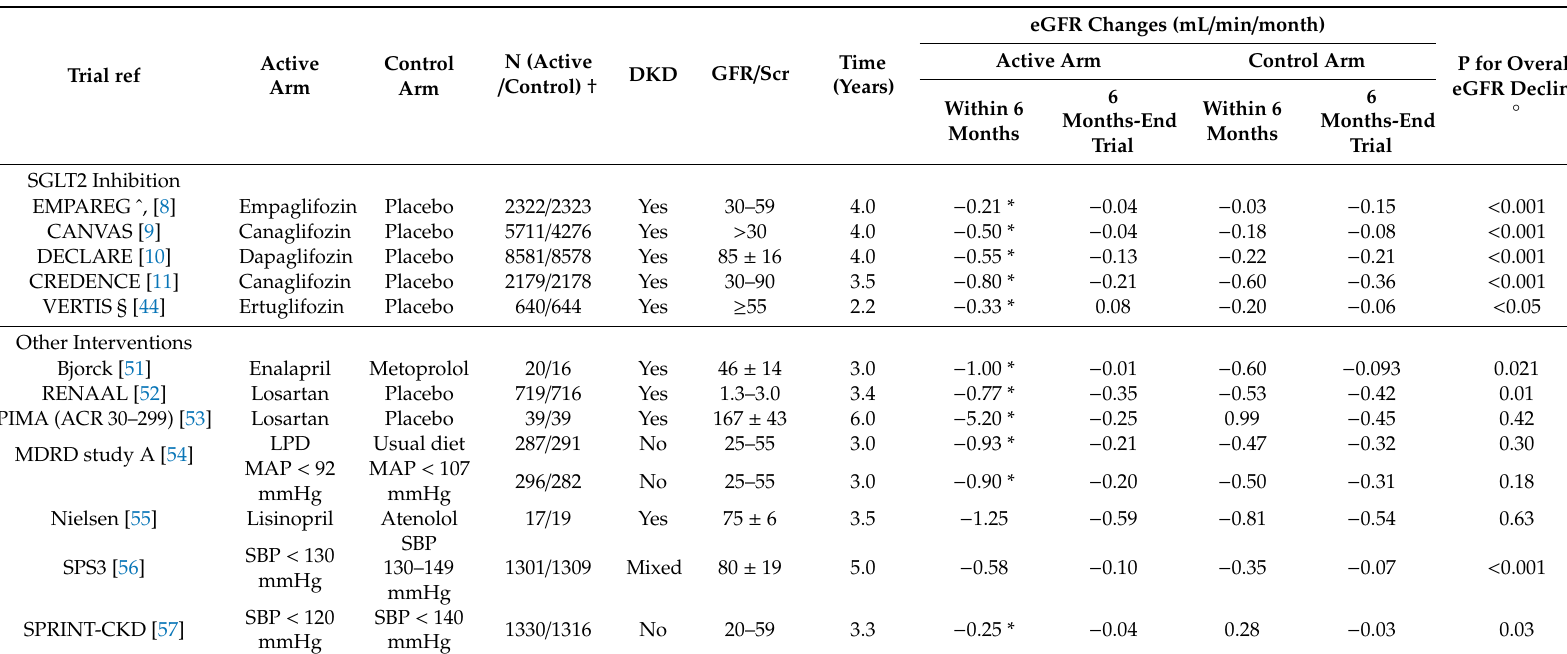
Table 1. GFR changes by period of follow up in the main randomized trials (RCTs) on SGLT2 inhibition in diabetic patients and in RCTs testing other interventions in chronic kidney disease (CKD)